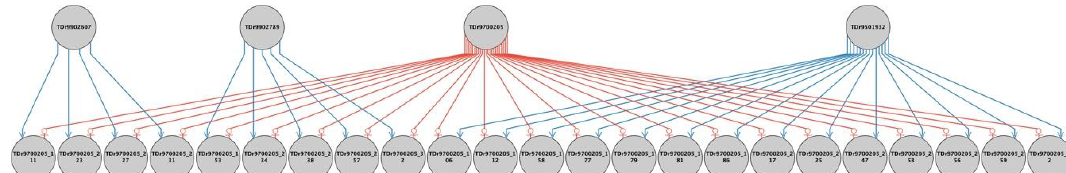
Figure 5. Pedigree reconstruction of polycross family TDr1688 based on Helium pedigree visualization . TDr9902607, TDr9501932 and TDr9902789 = male parents (blue); TDr9700632 = female parent (red).